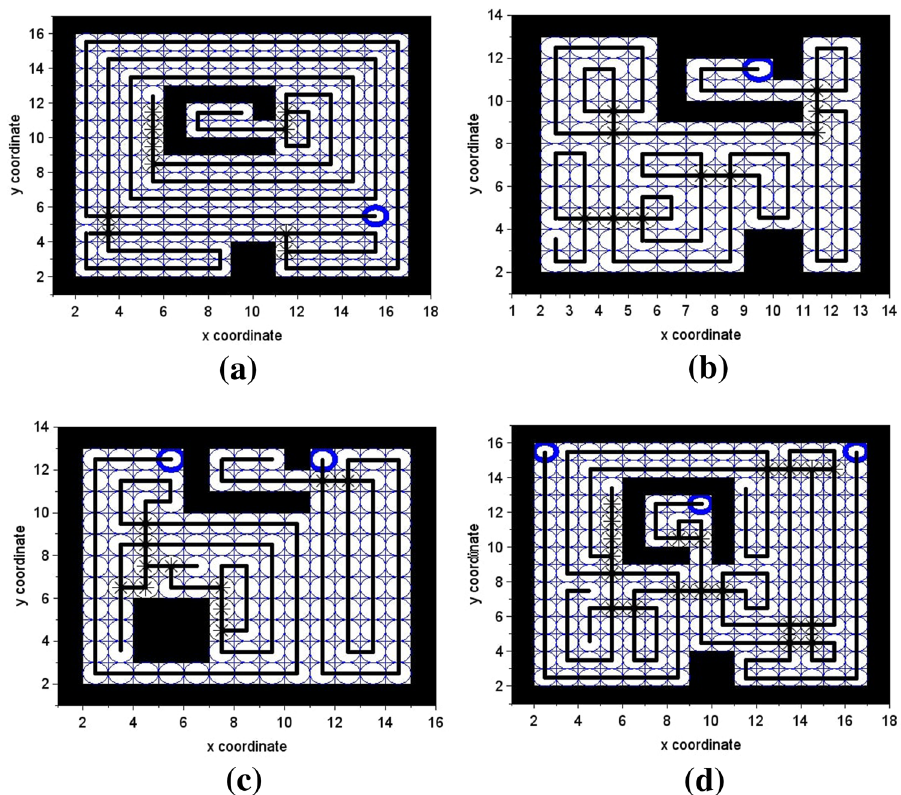
Fig. 7 An enclosed area with a single cell opening: a a single mobile robot starts from out- side; b a single mobile robot starts from inside; c two mobile robots start from outside; d three mobile robots- one starts from inside and others start from